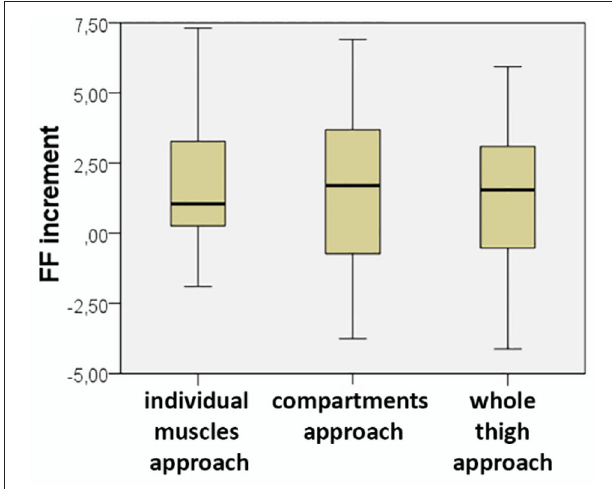
FIGURE 3 | Increment in fat fraction obtained with the three methods of analysis. There were no significant differences among them (Friedman p =